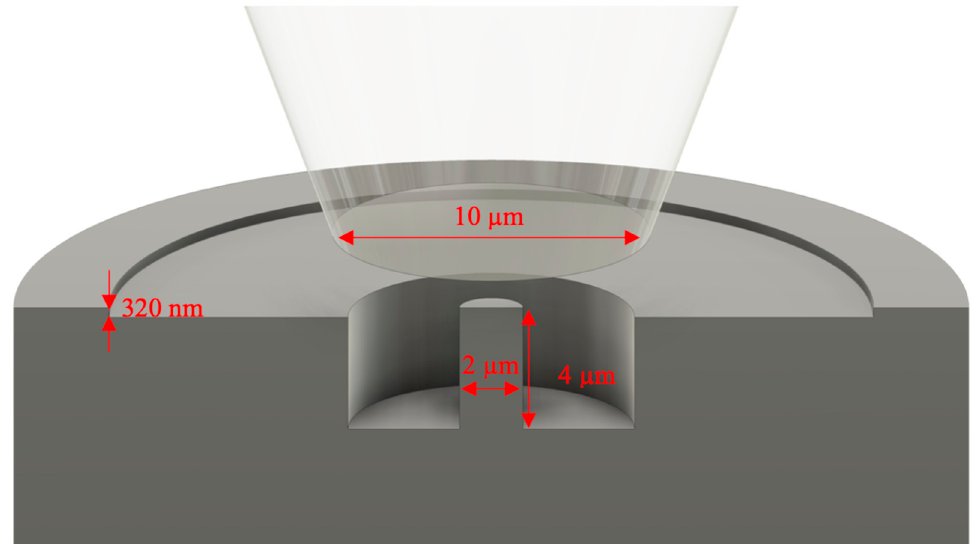
Figure 6. Staircase milling to control of the final pillar strain in the case of strain bursts too large to be reliably controlled using the nanoindenter. The shallow initial cut prevents the flat punch from further compressing the pillar once slip initiates.